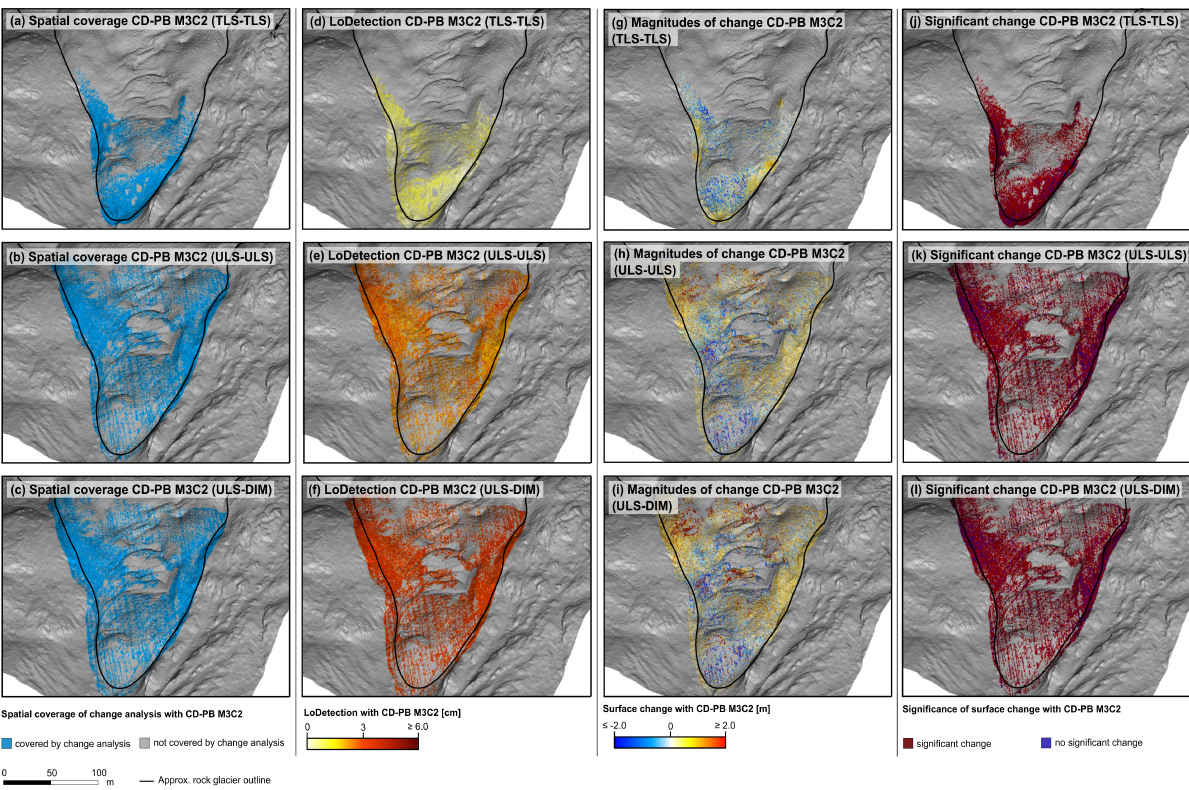
Figure 3. Results of CD-PB M3C2-based change analysis using point clouds derived from terrestrial laser scanning (TLS), UAV-borne laser scanning (ULS), and UAV-borne photogrammetry using dense image matching (DIM) as input. Spatial coverage (a) - (c), LoDetection (d) - (f), magnitudes of surface change (g) - (i), and significance of surface change (j) - (l) are shown on top of a hillshade